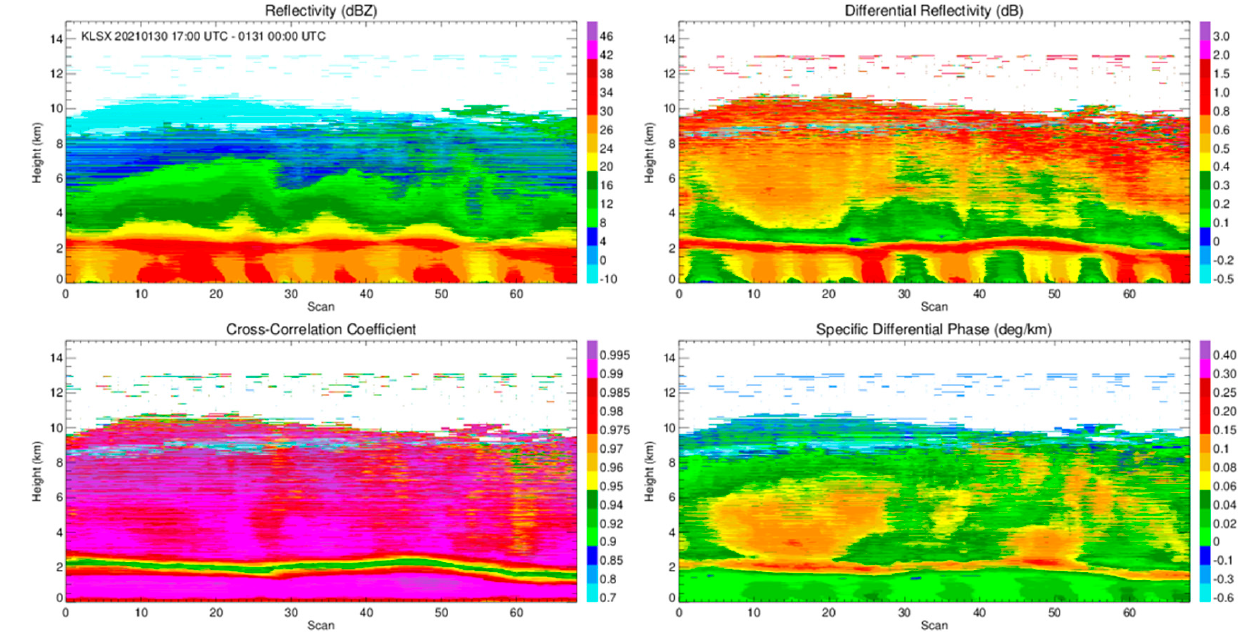
Figure 12. Range-defined quasi-vertical profiles (RD-QVP) of Z , Z DR , K DP , and ρ hv measured by the KLSX WSR-88D radar on 30 January 2021 for the period of 7 h starting on 1700 UTC.